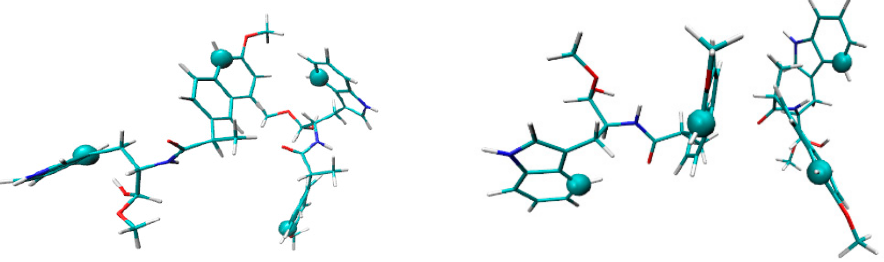
Figure 6. Dimer configurations for the ( S,S )-III. The case of the closest arrangement of a naproxen fragment with a tryptophan ( left ) and two naproxen residues ( right ). The spheres mark the atoms, the distance between which was taken for analysis.